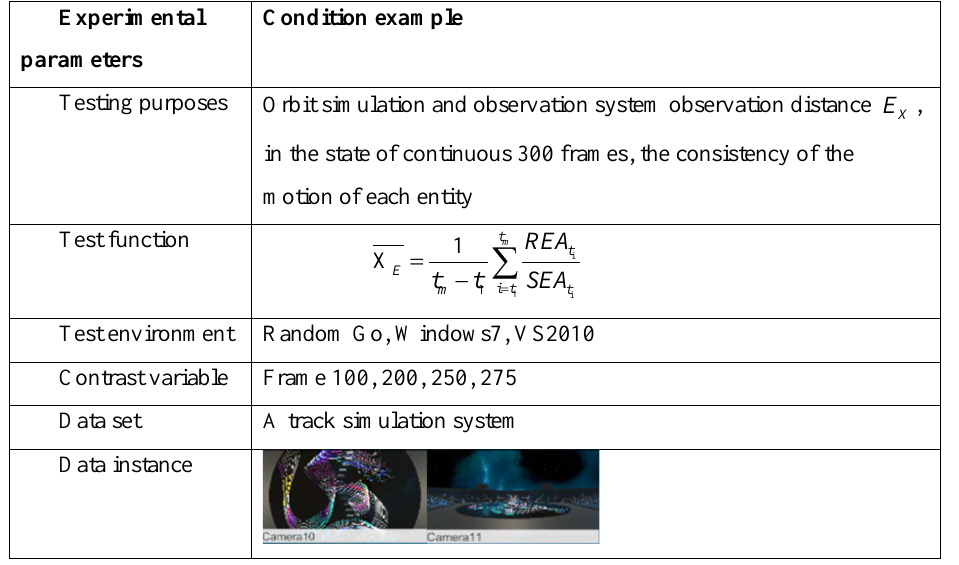
Table 2 Orbit simulation and observation system observation distance E X experimental information table